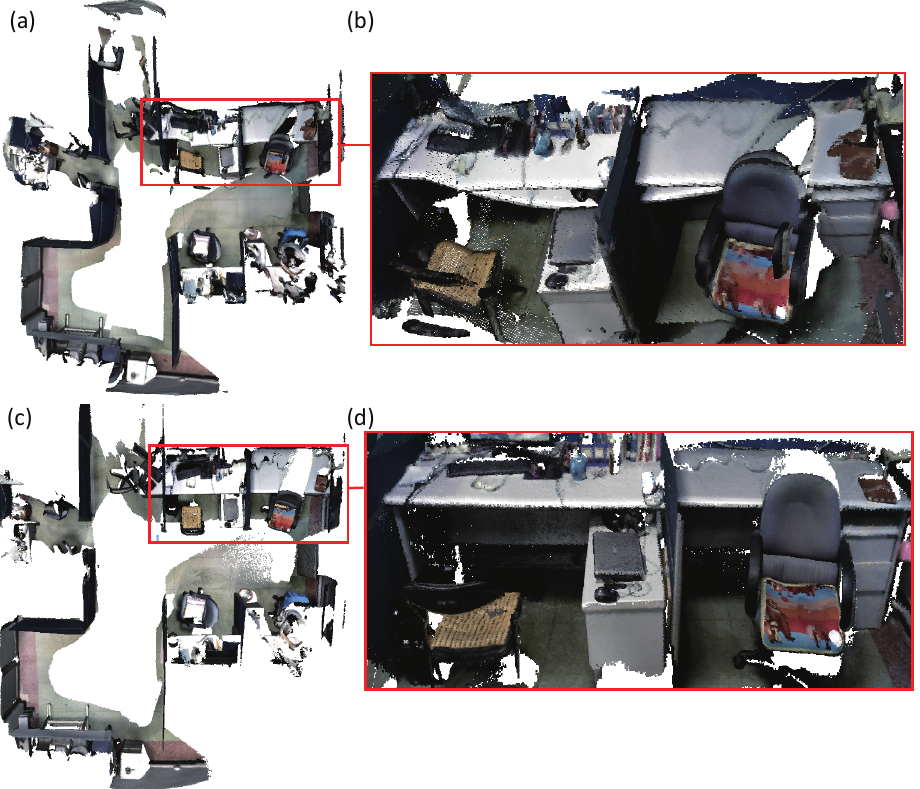
Figure 7. Reconstruction results of an office room. ( a ) is the 3D model produced by Kintinuous [36]. The system imported the trajectory generated by our system as ground truth when reconstructing the office room. ( b ) shows the details of the surface that produced around the loop closure. ( c ) presents the result generated by our system. The surface produced around the loop closure is displayed in ( d ).